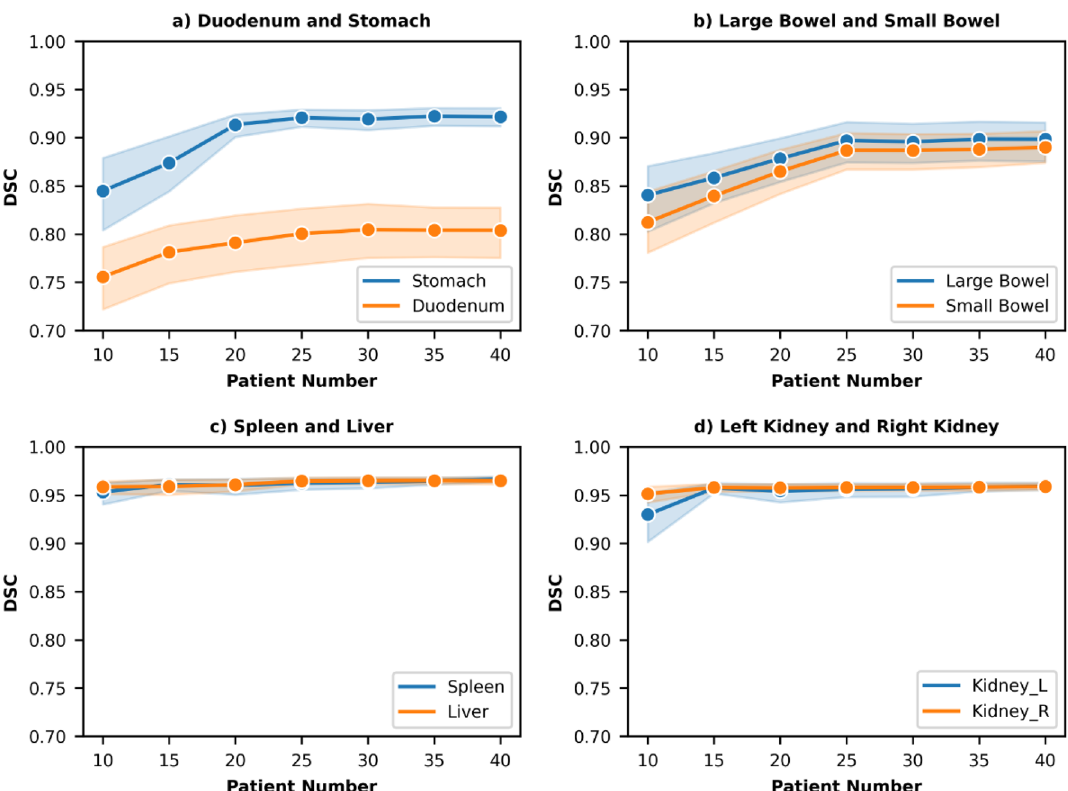
Figure 3. Mean DSC values between automatically generated contours and ground- truth contours increased as the number of patients in the dataset increased. The shadow represents the corresponding standard deviation for individual DSC